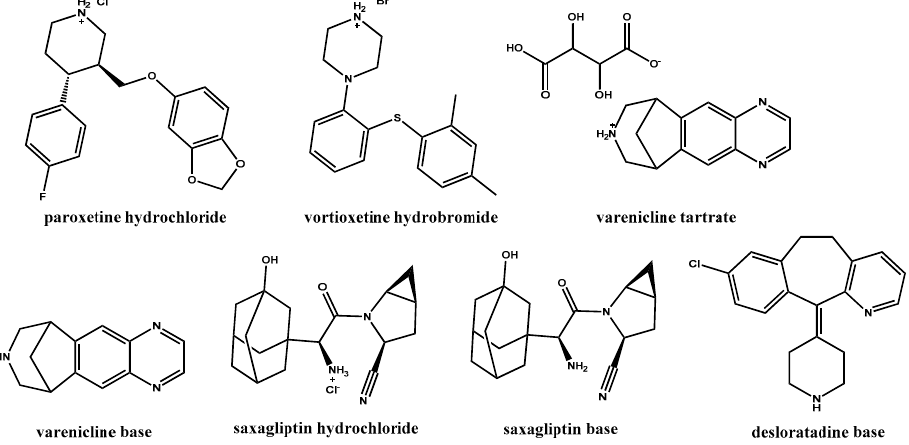
Figure 1. Model amine functionality containing drugs included in the study.